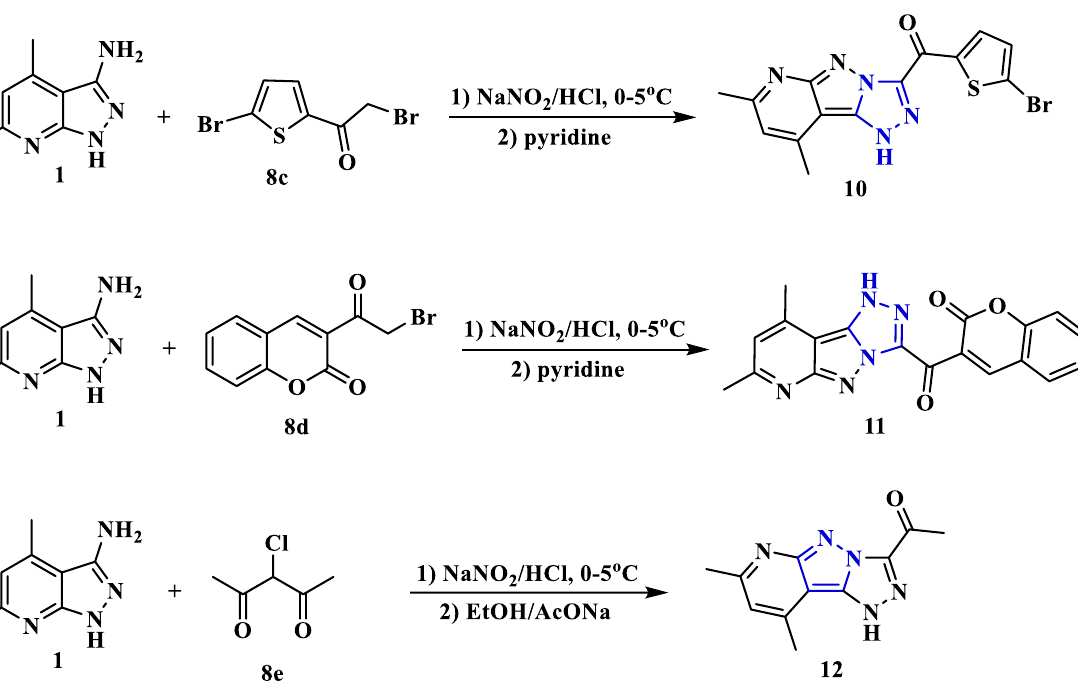
Figure 6. Synthesis of pyridopyrazolo-triazole derivatives 10 , 11 and 12 .